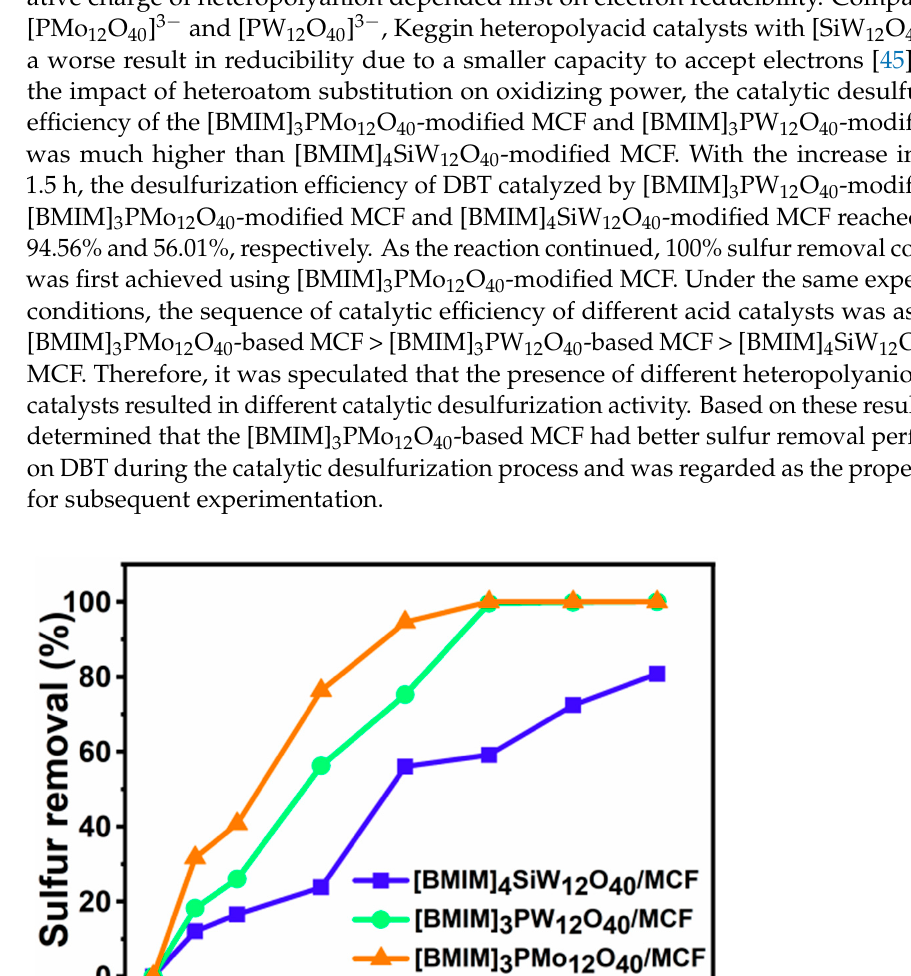
Figure 8. E ff ect of the amount of [BMIM] 3 PMo 12 O 40- based MCF on removal of DBT. Experimental conditions: T = 60 °C, V DBT = 5 mL, V IL = 3 mL, O/S = 6, and t = 3 h. 3.5. In fl uence of O/S Ratio on Sulfur Removal Due to its superiority, hydrogen peroxide plays an important role as an oxidant in the process of oxidative desulfurization. Stoichiometrically, 2 mol of hydrogen peroxide is required for the oxidation of sulfur components to the corresponding sulfones [46]. However, a higher oxygen/sulfur ratio (O/S) is needed in practice because of the compe- tition between the oxidation of DBT and the self-decomposition reaction of hydrogen peroxide. Accordingly, Figure 9 shows the e ff ect of the O/S ratio on sulfur removal using